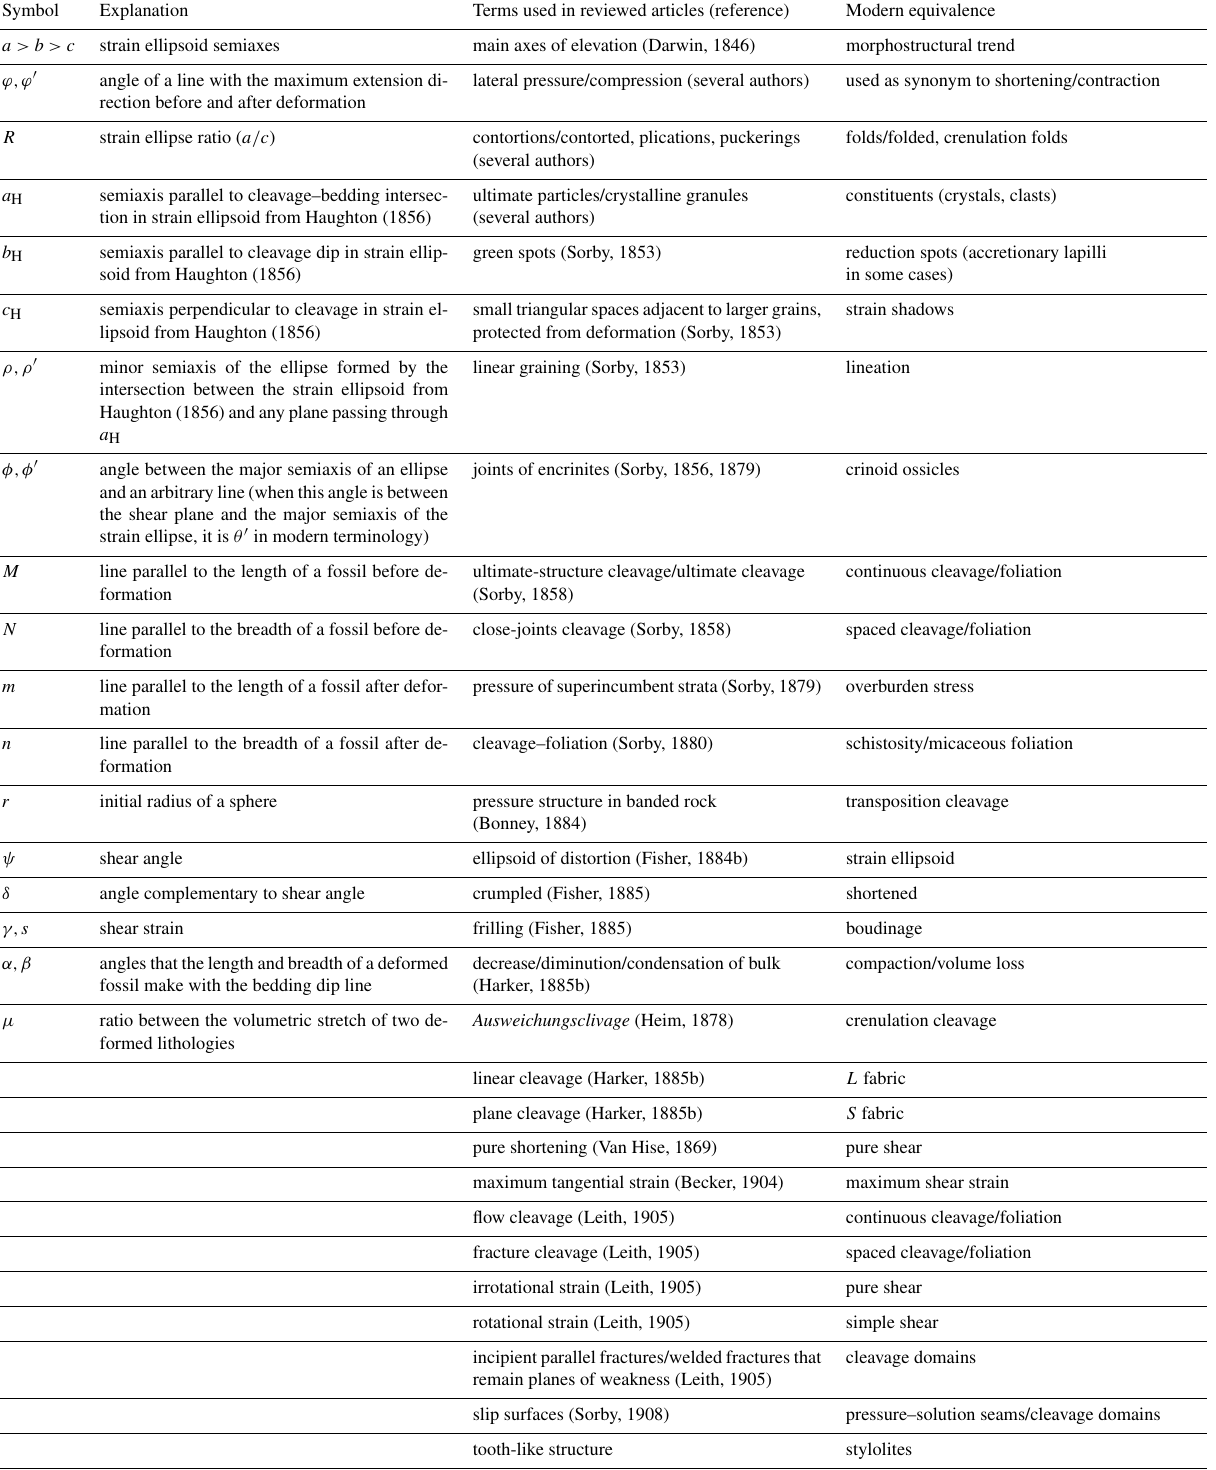
Table 1. Explanation of symbols used in the text and list of terms used in the revised bibliography with their modern equivalents. Symbol Explanation Terms used in reviewed articles (reference) Modern equivalence a > b > c strain ellipsoid semiaxes main axes of elevation (Darwin, 1846) morphostructural